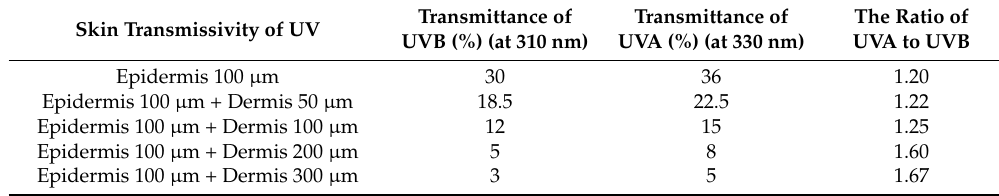
Skin Transmissivity of UV